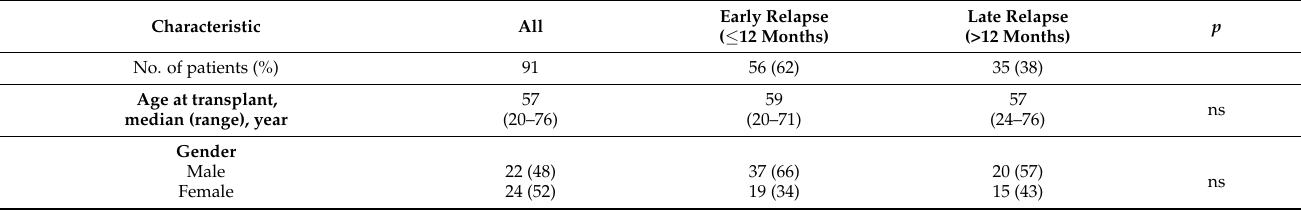
Table 1. Patient and disease